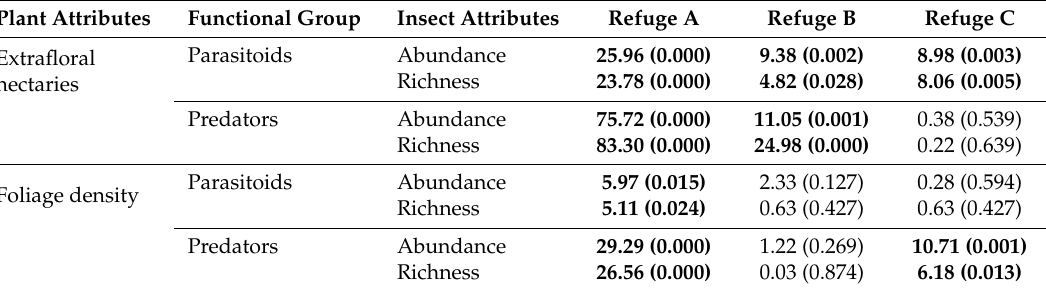
Figure 6. Abundance of two of the four main predator species occurring in maize ( Allograpta exotica and Orius insidiosus ), and three of their main preys ( Rhopalosiphum maidis , Aphis gossypii , and Aphididae sp. 1) during the sampling period in each refuge. Table 4. Results obtained from the Kruskal-Wallis tests between the parasitoid and predator assemblages’ attributes and the plant attributes, calculated separately for every refuge. The extrafloral nectaries in species from refuges A and B are present in bracts, whilst those present in Refuge C are in stipules. Tests for life form could not be done for Refuge A, since all plant species there were herbaceous. Significance level is shown between brackets. Values shown in bold were statistically significant ( p < 0.05)